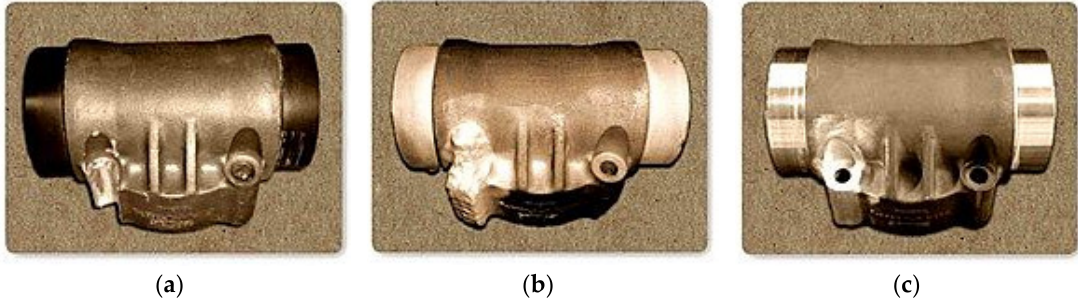
Figure 19. ( a ) Damaged flap transmission tee box housing, ( b ) cold spray coating applied and ( c ) machined after cold sprayed [62].